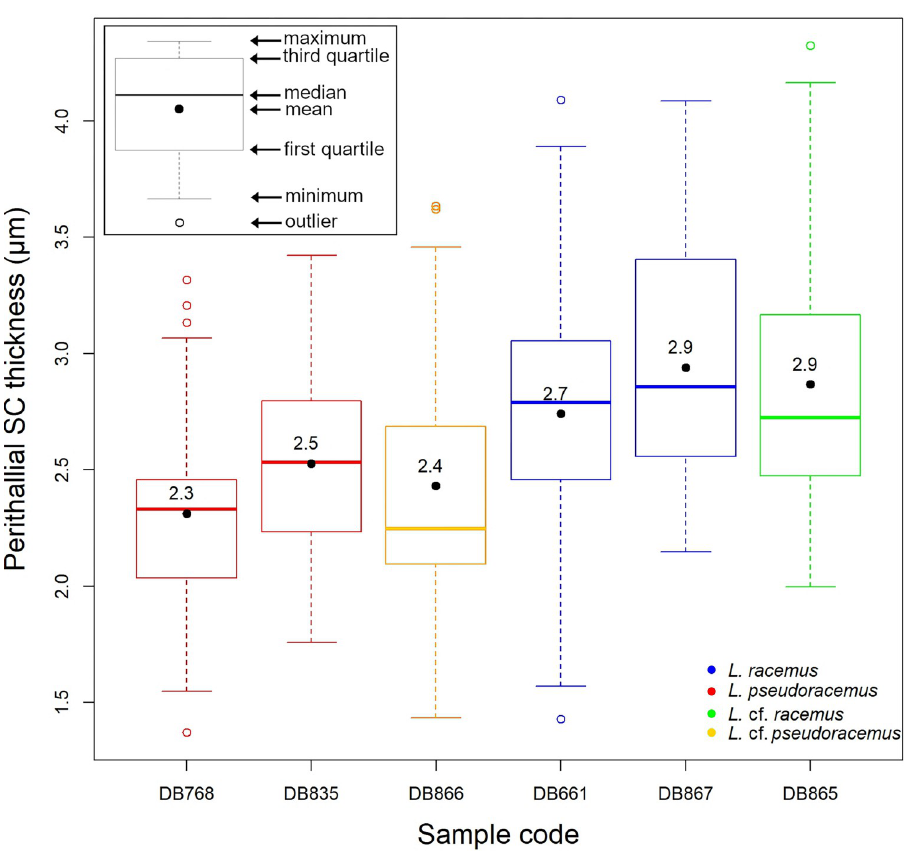
Fig 9. Box plot of the perithallial SC thickness. The numbers inside the plots indicate the mean values.